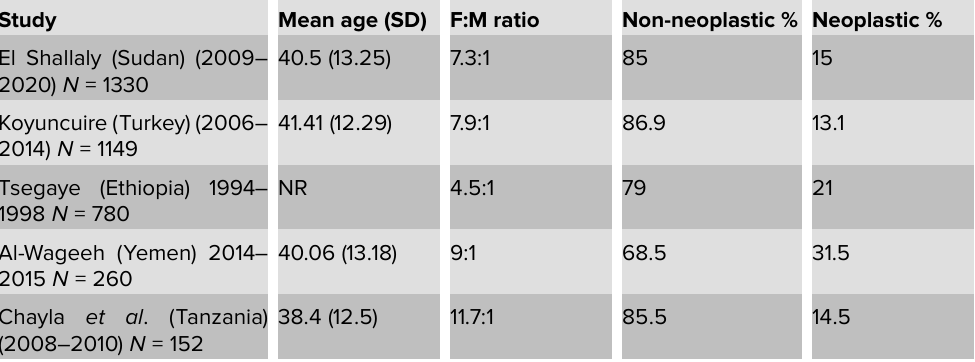
Table 2: Mean age, gender and non-neoplastic vs neoplastic ratios.